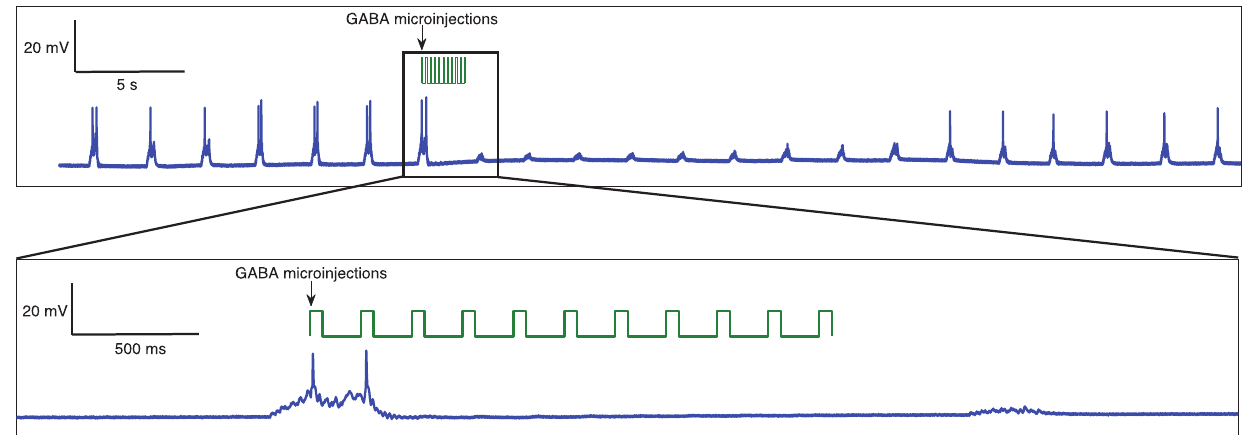
Figure 2. Transient effect of GABA microinjections on cardiac cells in a traditional open-loop protocol with periodic stimulation. The top panel shows the effect of GABA on the membrane potential of a CPG neuron from the cardiac ganglion of Carcinus maenas . The vertical arrow indicates the instant in which a burst of periodic GABA microinjections (vertical lines) of 50 ms of duration and separated by 200 ms takes place. These injections produce a transient inhibitory effect on the bursting activity. The bottom panel is a blow up of the squared region on the top panel. Single pulses evoke a much more transient response as shown in Fig. 4, which is used to control the number of spikes in each burst during the closed-loop experiment.